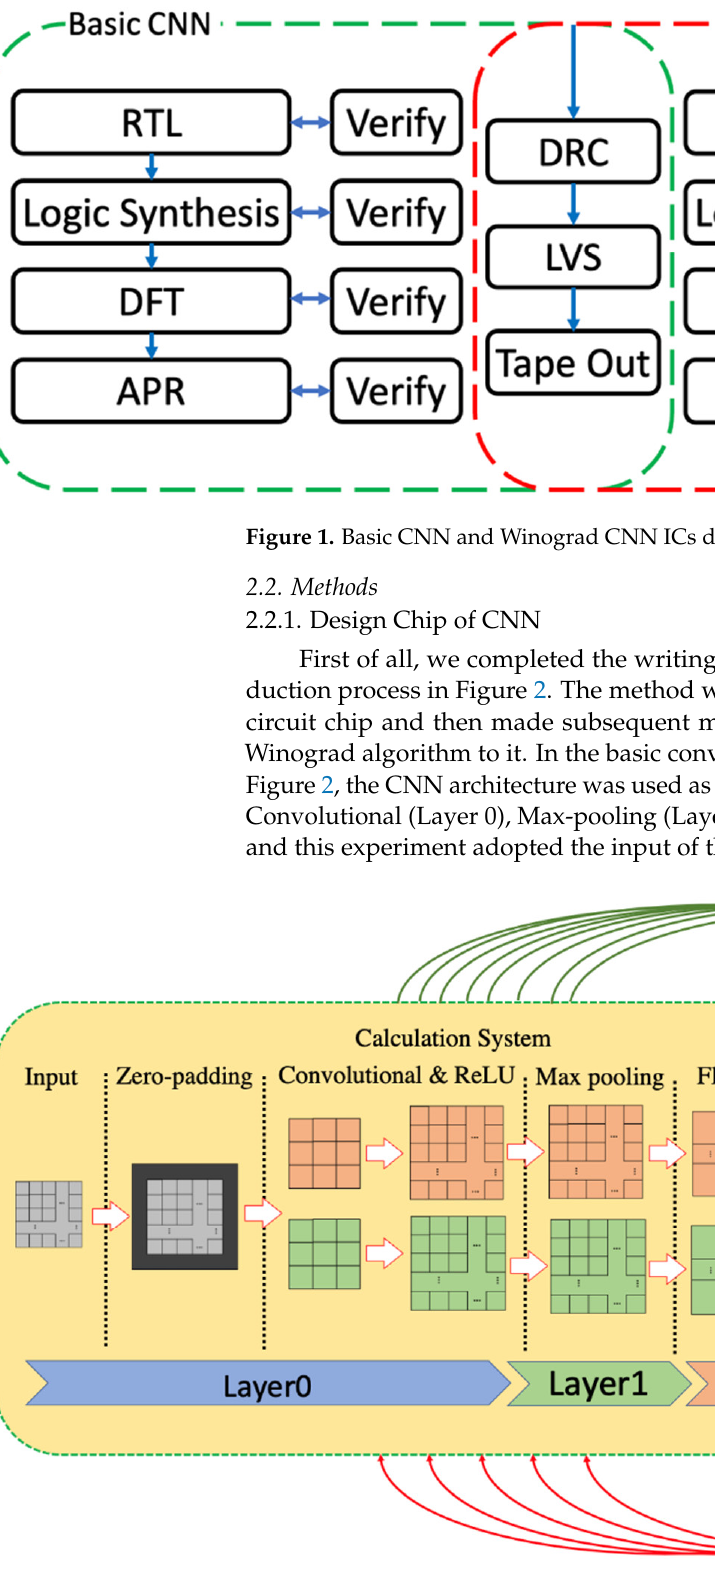
Figure 1. Basic CNN and Winograd CNN ICs design flow from RTL to Tape Out.